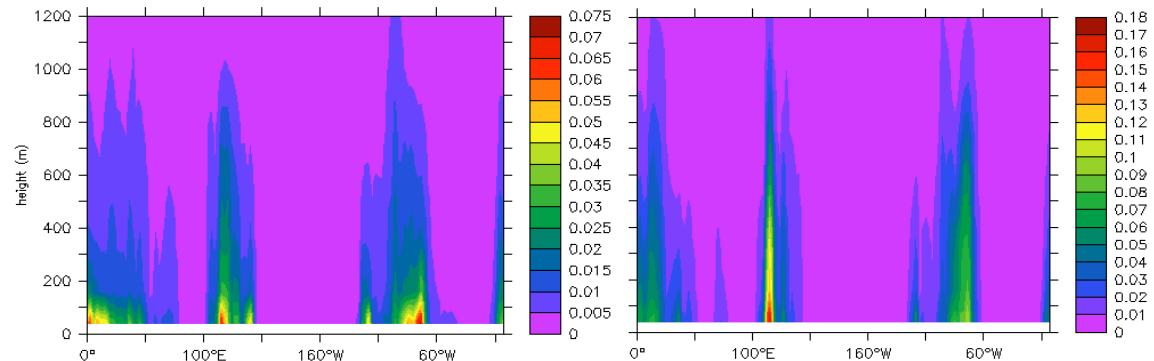
Fig. 12. Simulated one day average HONO mixing ratios (ppbv), averaged over the Northern Hemisphere (30 ◦ N to 50 ◦ N) during summer Figure 12: Simulated one day average HONO mixing ratios (ppbv), averaged over the (on 29 June 2005, left) and winter (on 30 December, 2005, right) within the first 1200m above the ground. northern hemisphere (30°N to 50°N) during summer (on 29 June, 2005, left) and only formation mechanism. The simulated HONO levels winter (on 30 December, 2005, right) within the first 1200 m above the ground.